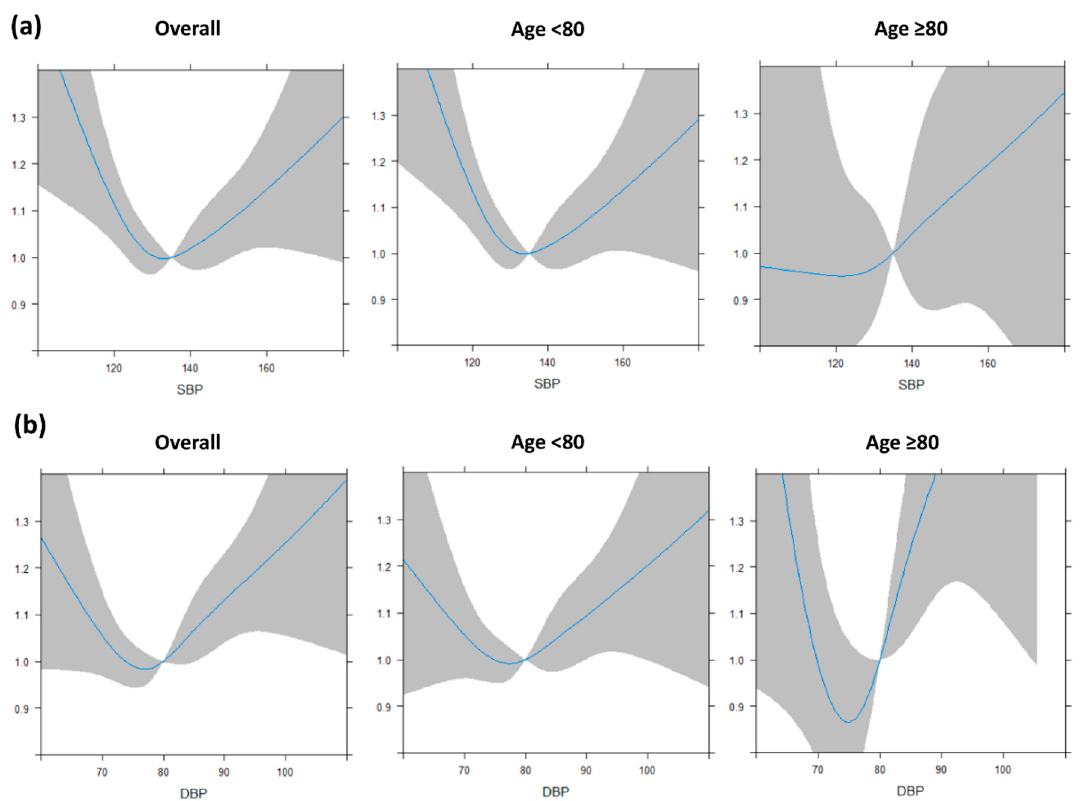
Figure 4. Systolic and diastolic blood pressure status of repeated measurement and risk of atrial fibrillation among elderly populations with antihypertensive medications: ( a ) systolic blood pressure and ( b ) diastolic blood pressure. SBP, systolic blood pressure; DBP, diastolic blood pressure. The blue line shows relationship between hazard ratio of new-onset AF and blood pressure, and the gray area indicates the degree of confidence.